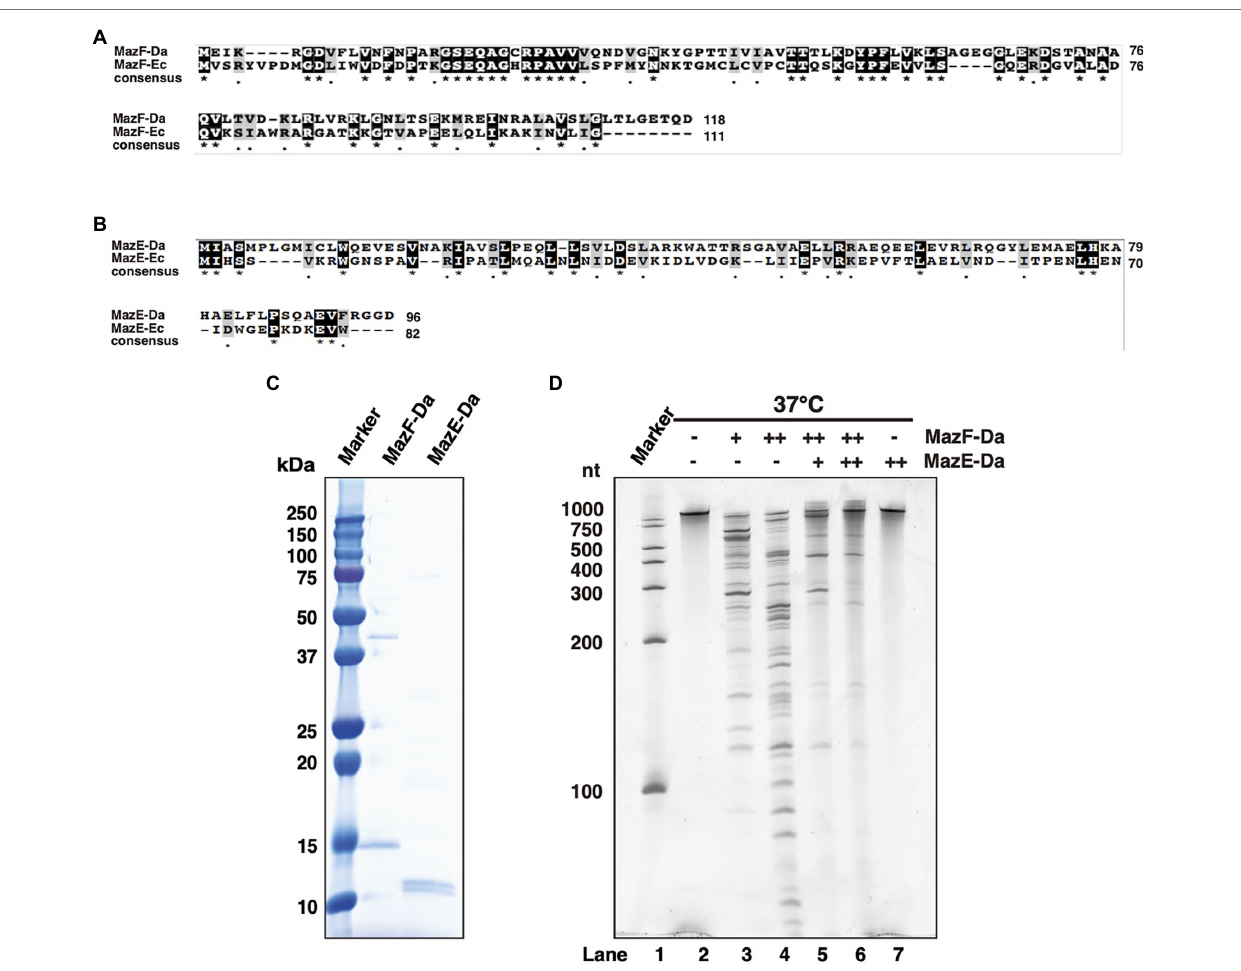
FIGURE 1 | Characterization of MazEF-Da. Alignment of the (A) MazF-Da and MazF-Ec as well as the (B) MazE-Da and MazE-Ec amino acid sequences. For both (A) and (B) , identical amino acid residues are highlighted as black squares and highly similar amino acid residues are highlighted as gray squares. Asterisks indicate 100% identity between the two sequences and dots indicate 80% similarity between the two sequences. (C) The molecular weight and purity of MazE-Da and MazF-Da were assessed using SDS- PAGE and visualized using Coomassie Brilliant Blue (CBB) staining. (D) Substrate RNA (RNA 1500–1) was incubated at 37 ° C for 90 min with MazE-Da and/or MazF-Da; lane 1, marker; lane 2, negative control without enzymes; lane 3, 1 pmol of MazF-Da; lane 4, 10 pmol of MazF-Da; lane 5, 10 pmol of MazF-Da and 20 pmol of MazE-Da; lane 6, 10 pmol of MazF-Da and 40 pmol of MazE-Da; lane 7, 40 pmol of